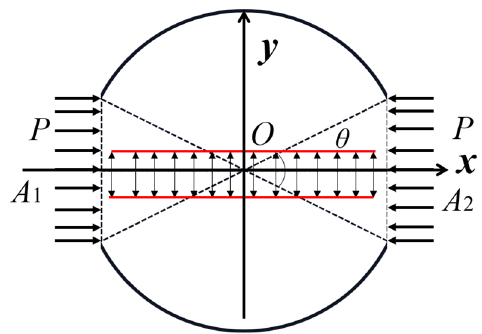
Figure 5. The flattened Brazilian test.